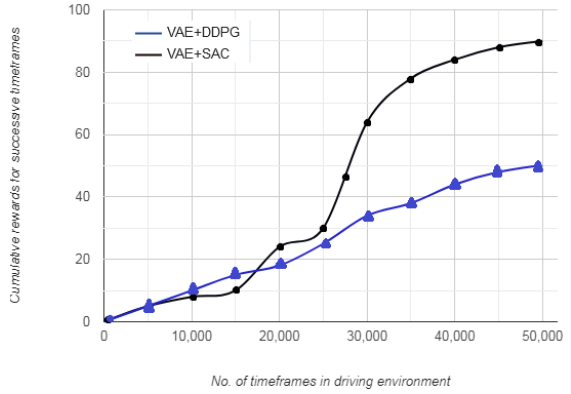
Figure 7. Cumulative reward vs. no. of